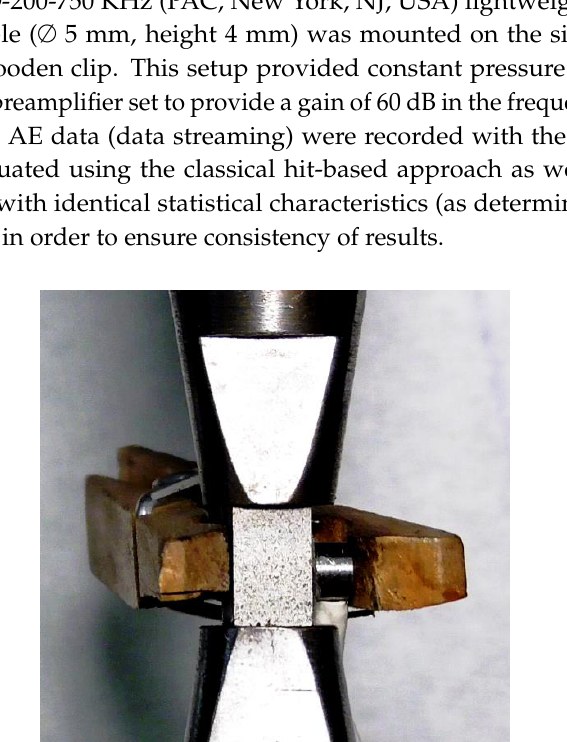
Figure 3. Picture of the experimental setup and mounting of the AE sensor.